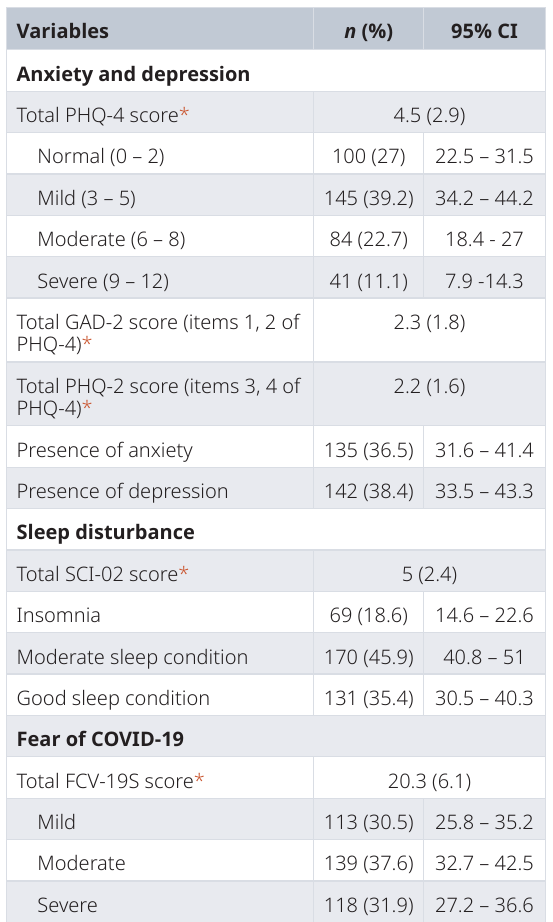
Table 3. Psychological burden among frontline doctors of Bangladesh during the COVID-19 pandemic (n=